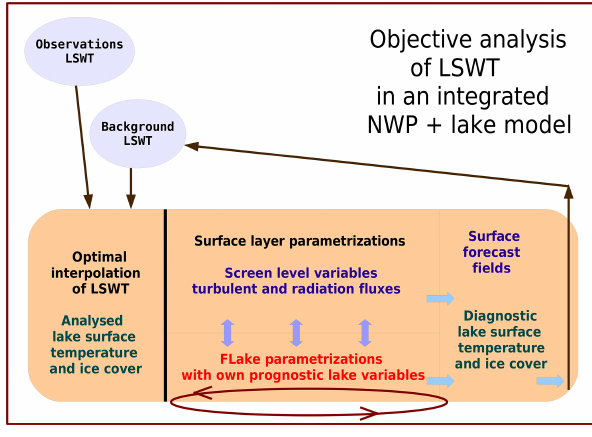
Figure 1. Coexistence of the independent objective analysis of the observed LSWT and prognostic FLake parametrizations in HIRLAM. The thin arrows are related to data flow between HIRLAM analysis–forecast cycles while the thick arrows describe processes within each